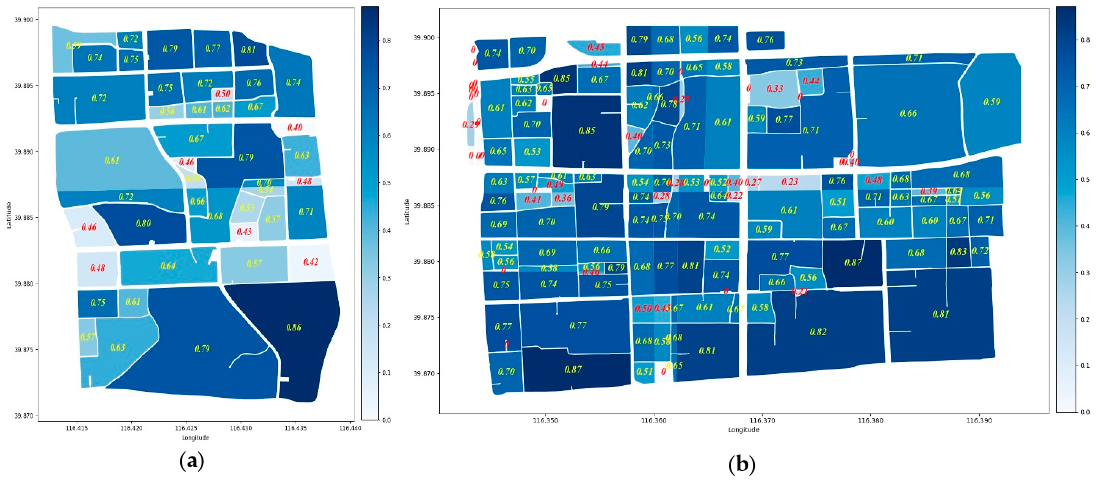
Figure 11. Illustration of mixed land use (red numbers within parcels represent the MLU less than 0.5): ( a ) MLU of Parcel 1 , and ( b ) MLU of Parcel 2.